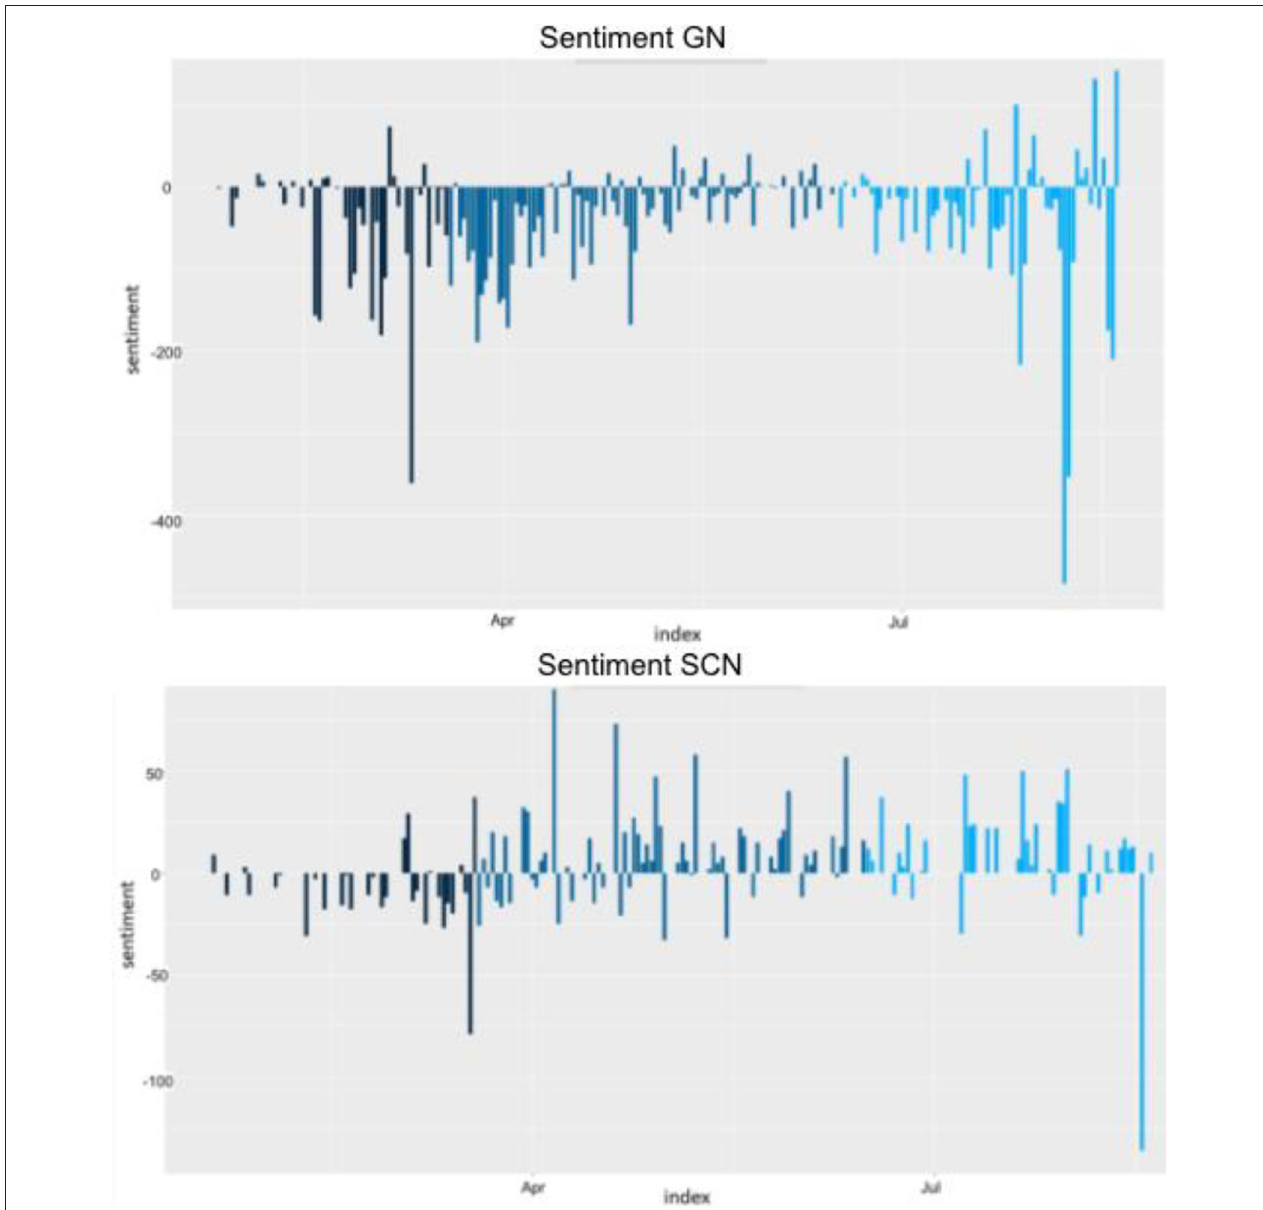
FIGURE 3 | Bing dictionary sentiment analysis (dark blue, onset; blue, wave 1; light blue, wave 2).